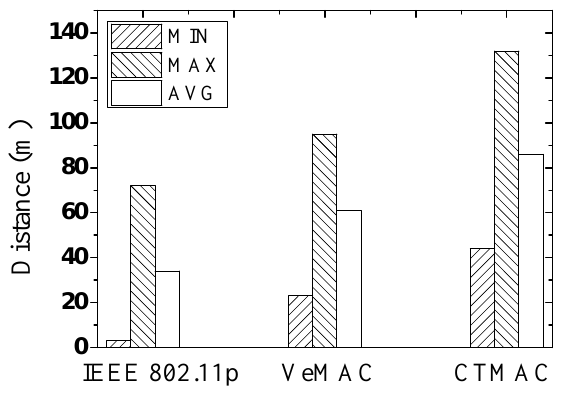
Figure 11. The minimum, maximum, and average distance between two consecutive vehicles.